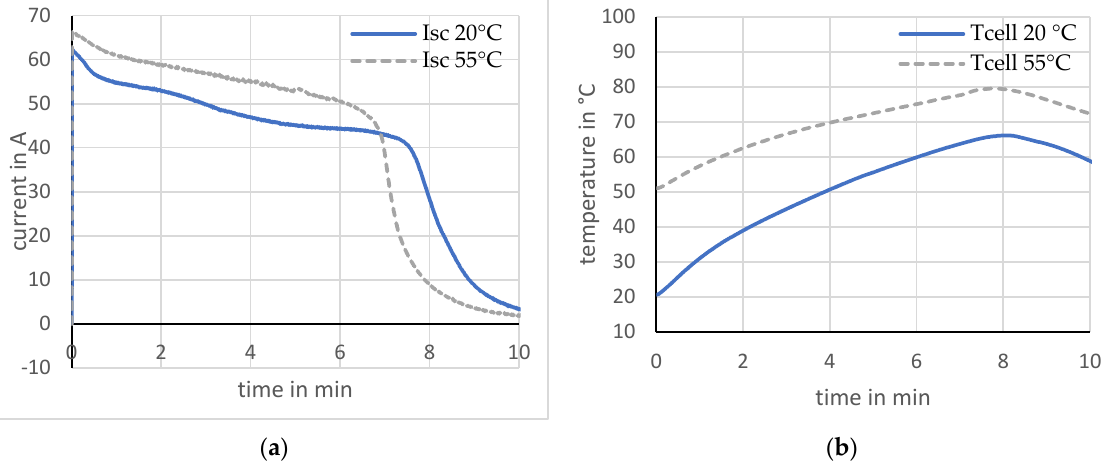
Figure 9. Short-circuit at different ambient temperatures. ( a ) Current; ( b ) Temperature.